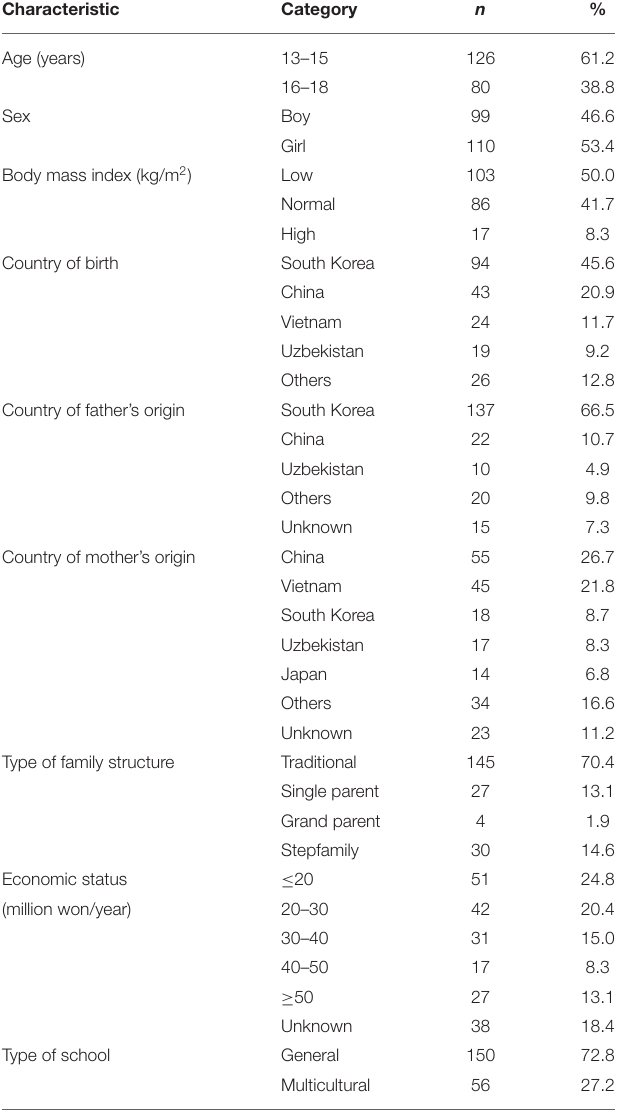
loading of CFA is presented in Table 2 . The structural model with all the hypothesized relationships is presented in Figure 2